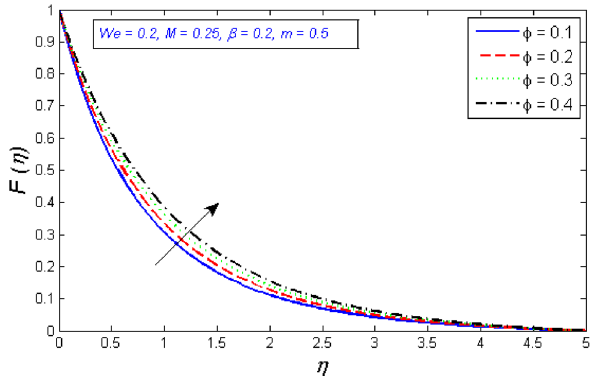
Figure 2. Represents variation of radial velocity distribution for several number of volume fraction φ .